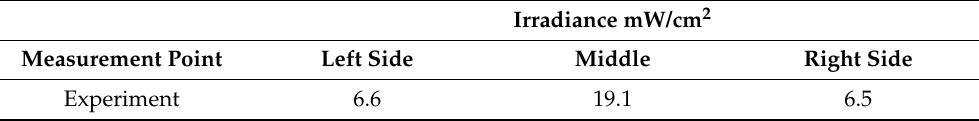
Figure 6. ( A ) Representative curve of massage therapy testing subject; ( B ) Representative curve of thermal testing subject. For ( A ) and ( B ), top: Light mode; middle: Middle mode; bottom: High mode. Table 3. LLLT experimental results.